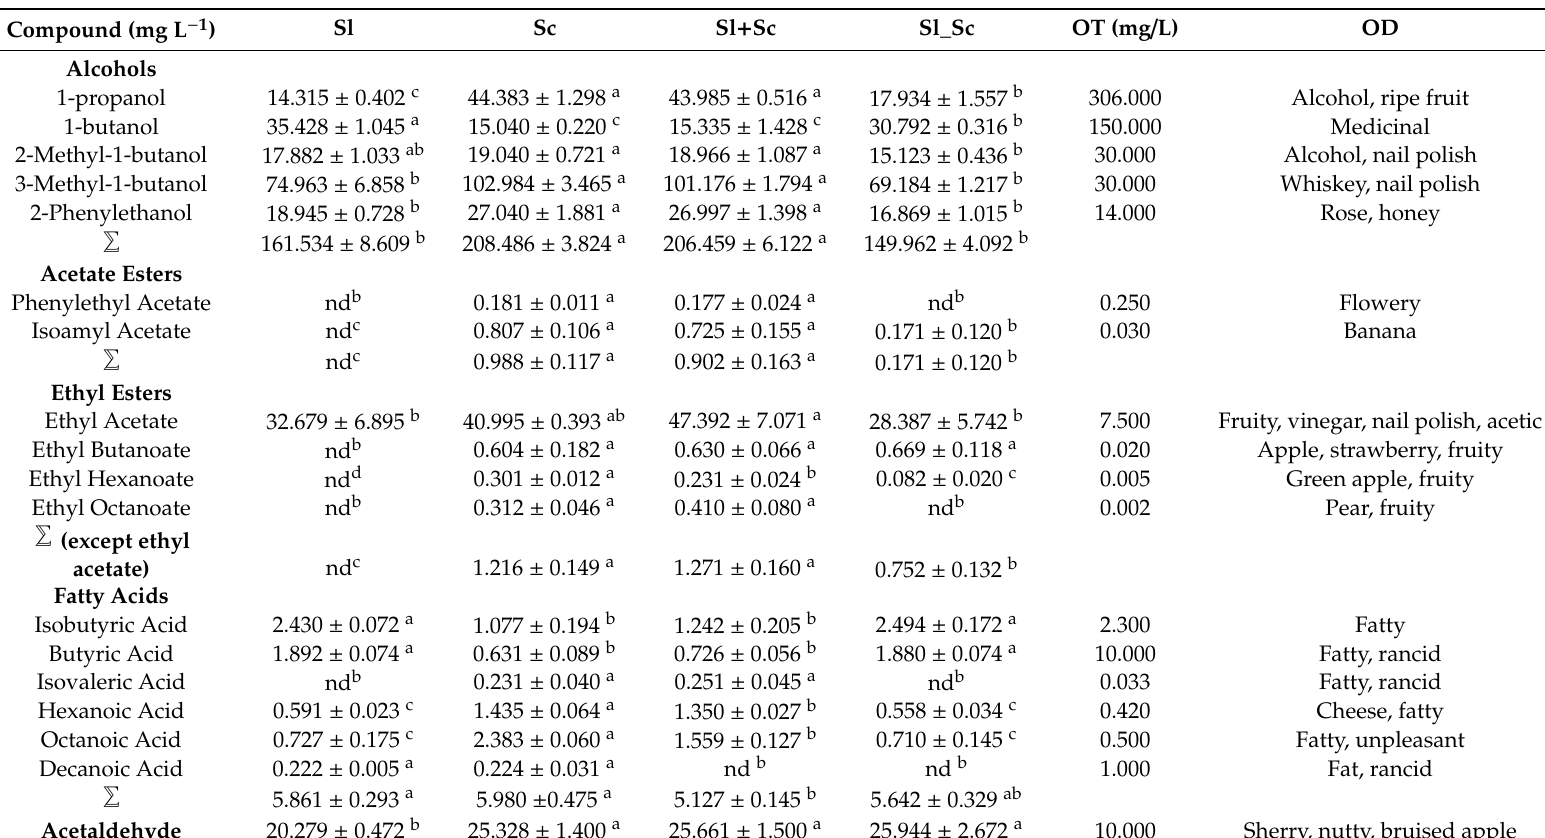
Table 2. Concentration of volatile compounds detected and quantified by Gas Chromatography equipped with Flame ionization Detector (GC–FID) in wine obtained by a single-culture of S. ludwigii UTAD17(Sl) and S. cerevisiae (Sc) or in consortium—mixed simultaneous (Sl+Sc) and sequential (Sl_Sc), in natural grape-juice of Vitis vinifera L. cv. Touriga Nacional at 25 °C, under static conditions.